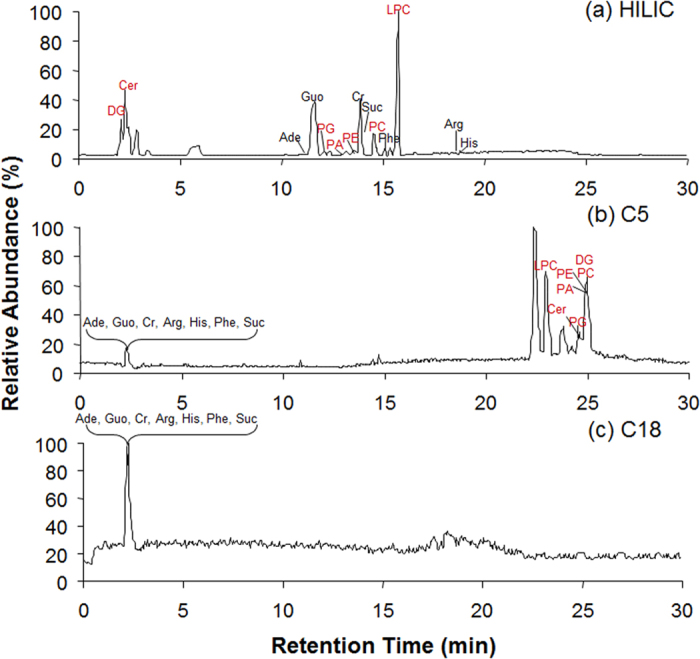
Total ion chromatograms of the standard mixture of 7 polar metabolites and 7 lipids on (a) Silica HILIC, (b) C5 and (c) C18. Ade: adenine; Guo: guanosine; Cr: creatinine; Arg: L-Arginine; His: L-histidine; Phe: L-phenylalanine; Suc: sucrose; LPC: LPC (17:0); PC: PC (17:0/17:0); PE: PE (17:0/17:0); PA: PA (17:0/17:0); PG: PG (17:0/17:0); Cer: Cer (d18:1/17:0(2S-OH)); DG: DG (15:0/15:0).